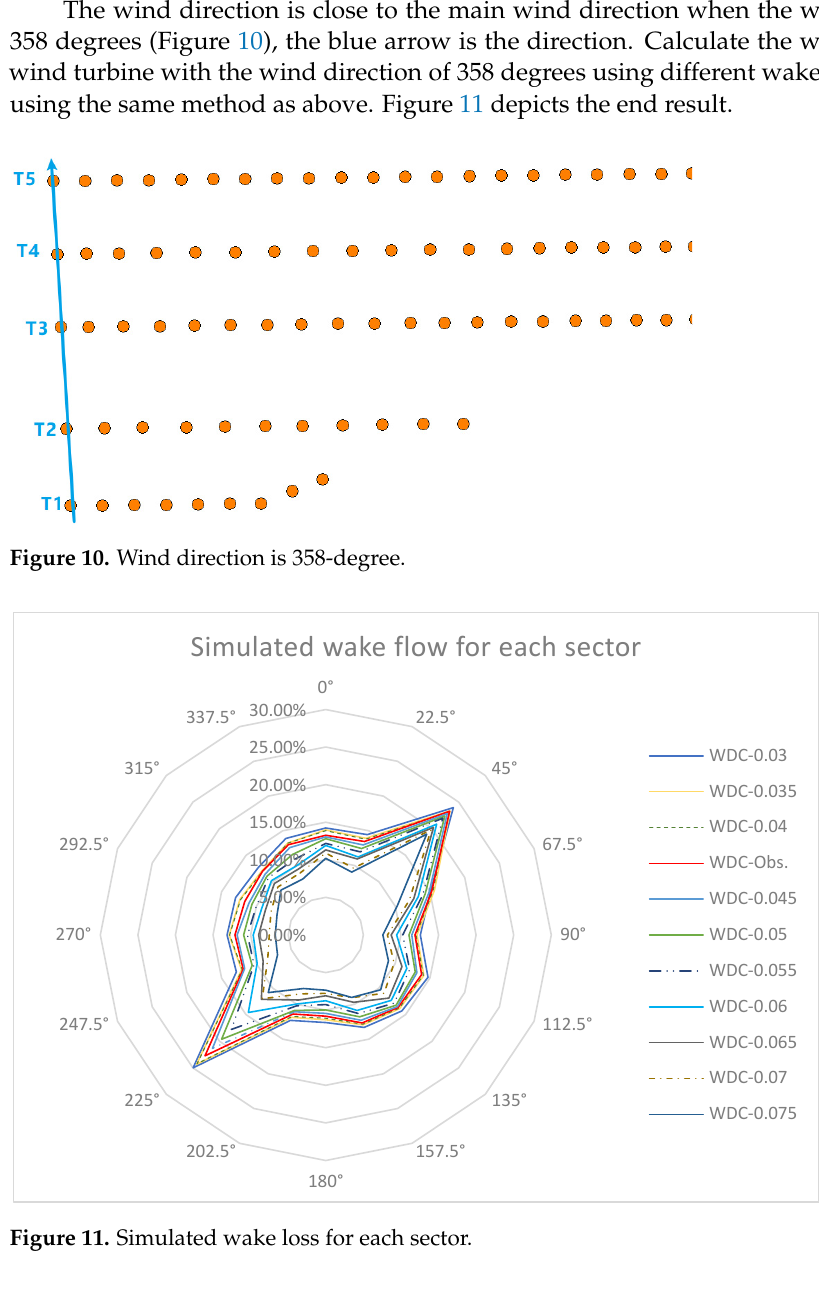
The wind direction is close to the main wind direction when the wind direction is 358 degrees (Figure 10), the blue arrow is the direction. Calculate the wake loss for the wind turbine with the wind direction of 358 degrees using different wake decay constant using the same method as above. Figure 11 depicts the end result.